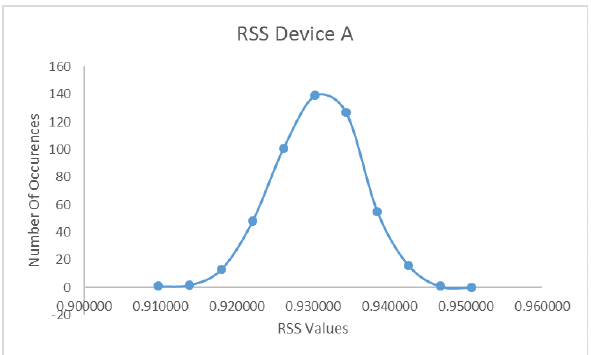
Figure 4. Root square Sum (RSS) for Device A.